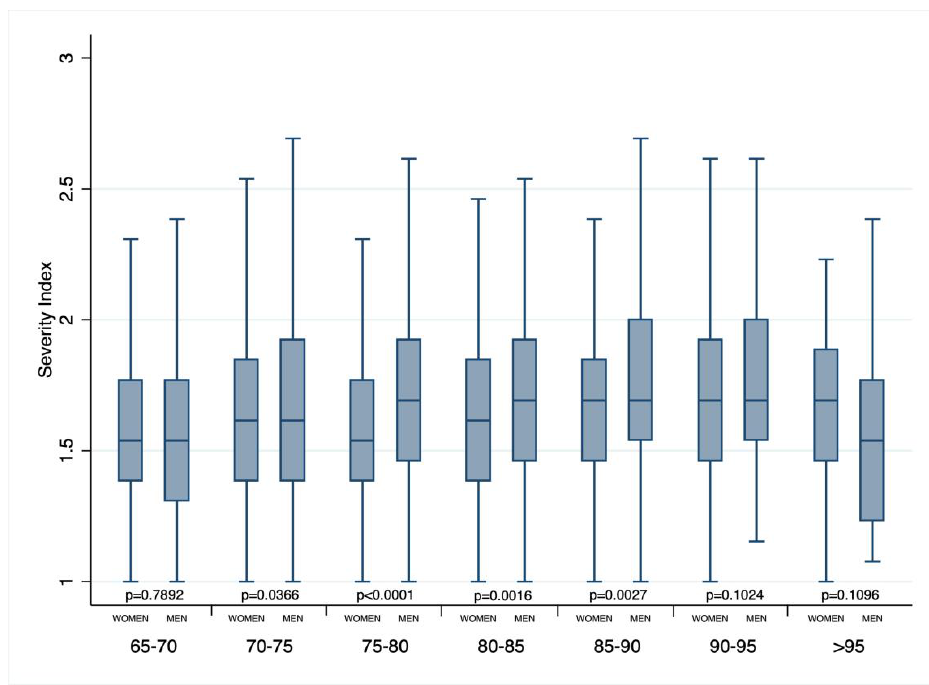
Figure 3. Box-whisker plot of severity index according to sex and age classes.